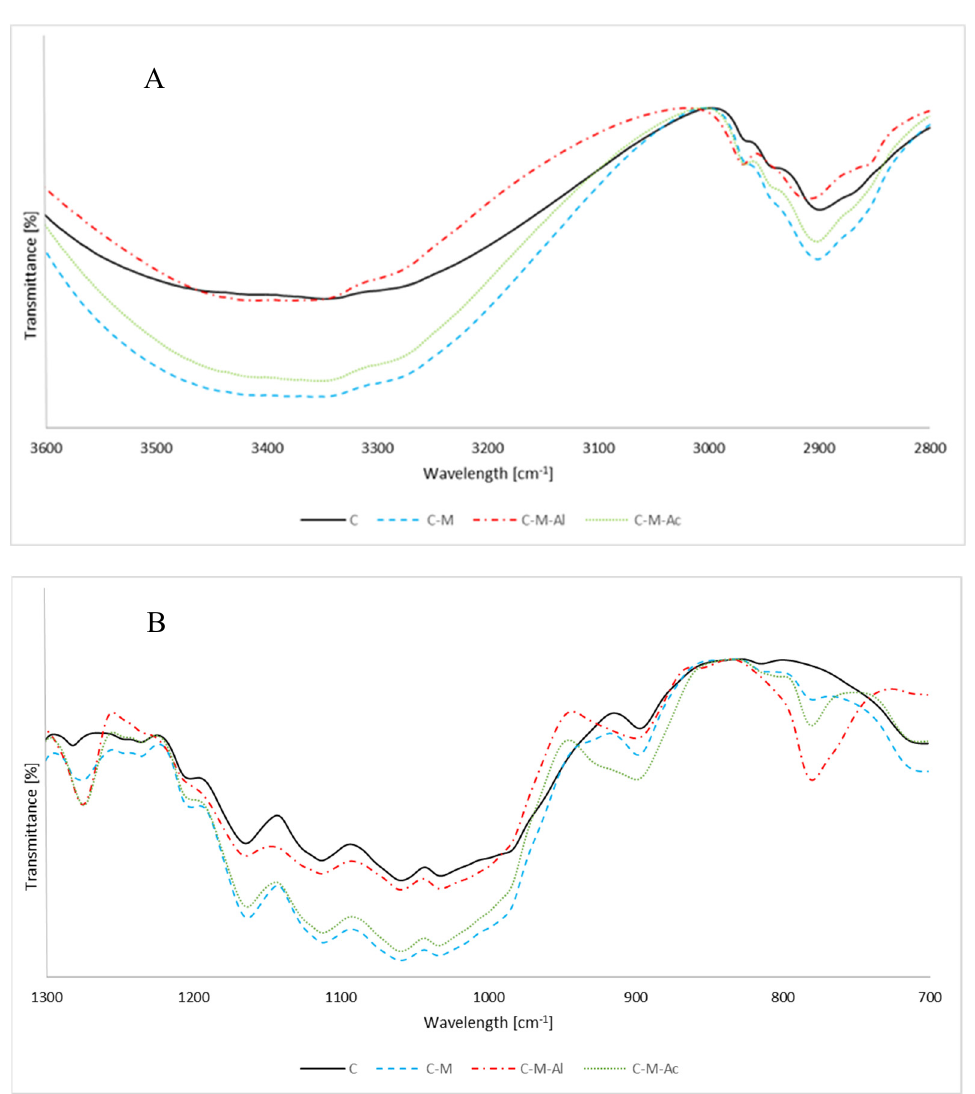
Figure 3. FT-IR spectra of silanizated cellulose at the 3600 to 2800 cm − 1 range ( A ), and at the 1300 to 700 cm − 1 range ( B ).